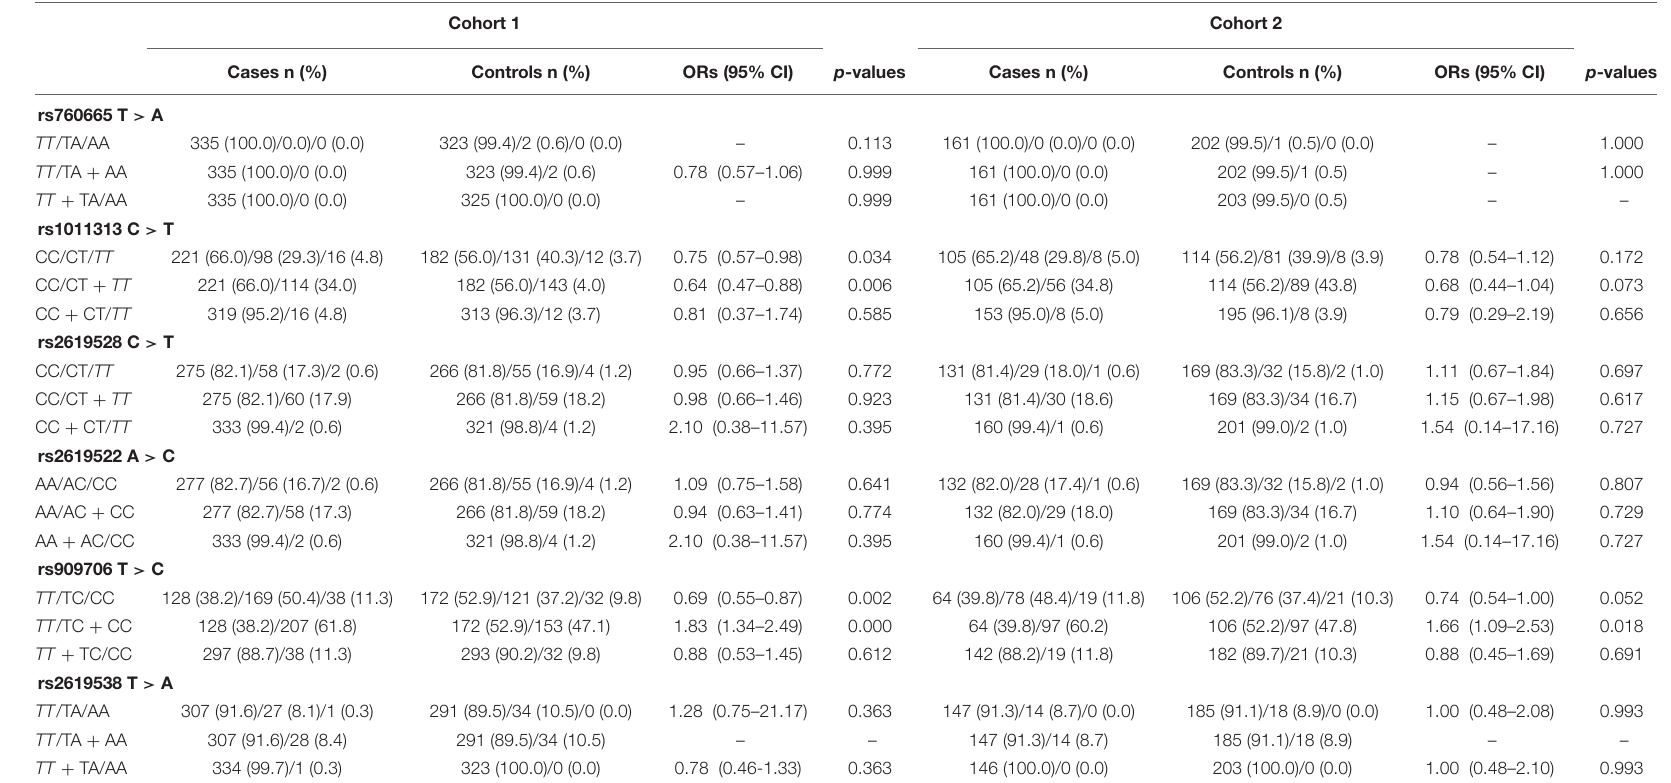
TABLE 2 | Inheritance models of the DTNBP1 SNPs in cohorts 1 and